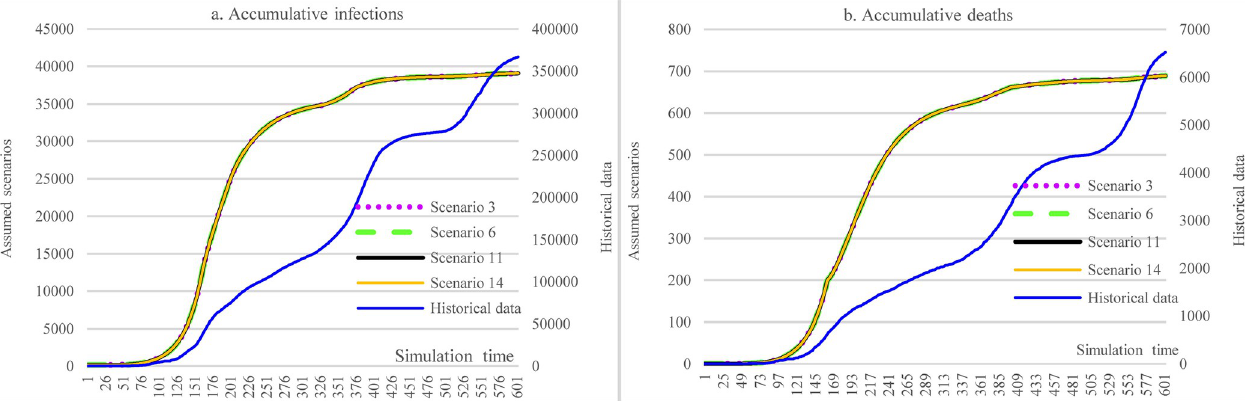
PLOS ONE | https://doi.org/10.1371/journal.pone.0271231 July 26,